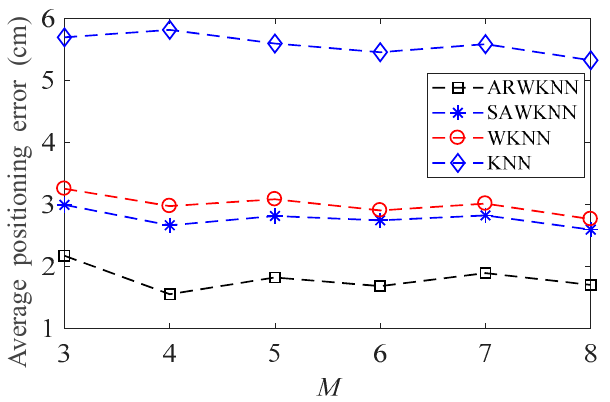
= 4. Sensors 2020 , 20 , x FOR PEER REVIEW max